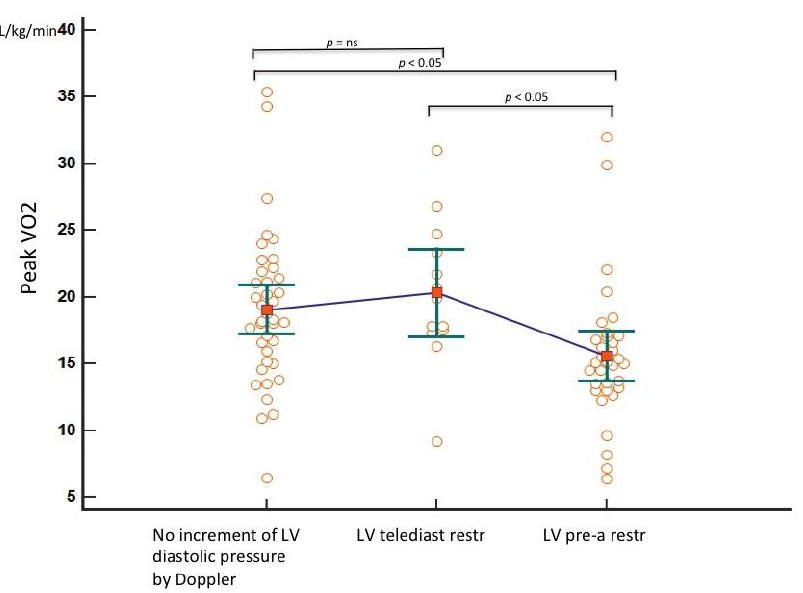
Figure 6. Means plot to compare the peak VO 2 in three different categories of progressively increased LV filling pressure by TEE. Only the third group (pre-A increase in pressure) is significantly different from the first (no increase in LV filling pressure) and the second (isolated LV telediastolic restriction). For each group, the individual peak VO 2 values with the mean and the standard error of the mean are reported. LV = left ventricle; telediast restr = telediastolic restriction (isolated increased telediastolic filling pressure); pre-a restr = increased pre-a pressure; ns = not significant. Other extracardiac parameters. Greater age, female gender, higher BMI, diabetes, and